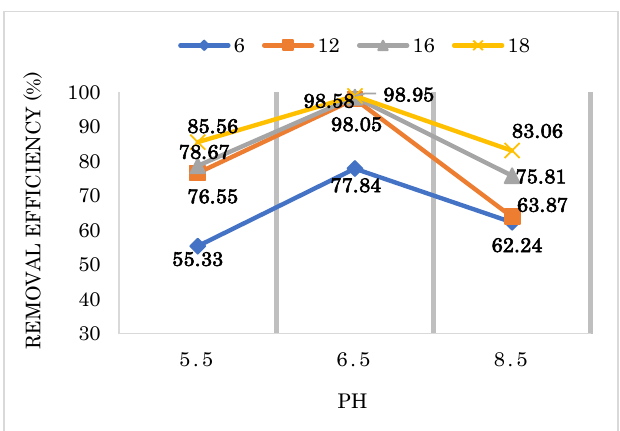
Fig. 10. pH optimization for total coliform removal for 3 A 3.2.1 Effect of operational parameters on total coliform removal Figs. 7 and 9 present the impact of contact time on total coliform removal efficiency. The experiments were carried out to determine the removal percentage at various time lapse i.e. 6, 12, 16, 18 min. The removal efficiency increases quickly and reaches to 98% at 12 min and provides the constant removal